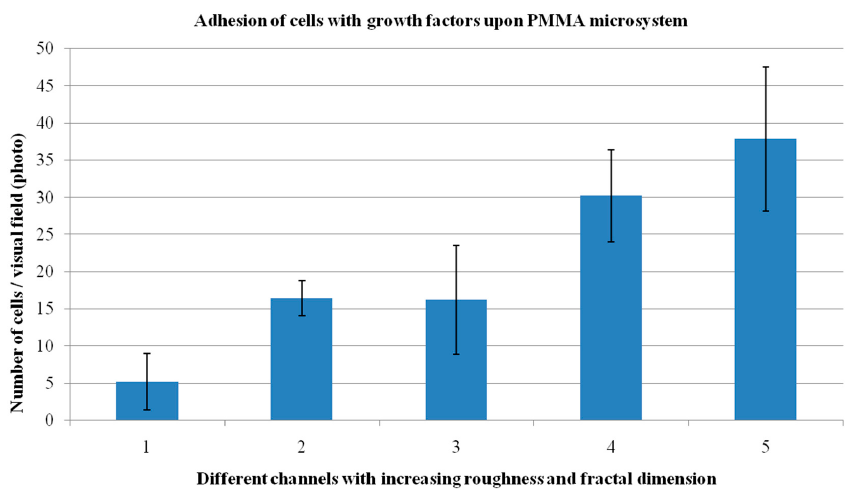
Figure 3. Results from the adhesion study of cells with TFs medium cultured on the fractal microsystem: Summary of the influence of channel topography on cell adhesion. Table 2. Results from the ANOVA test. Estimates for the different channels with the expected upper and lower limits for adhered cells per visual field in each channel.